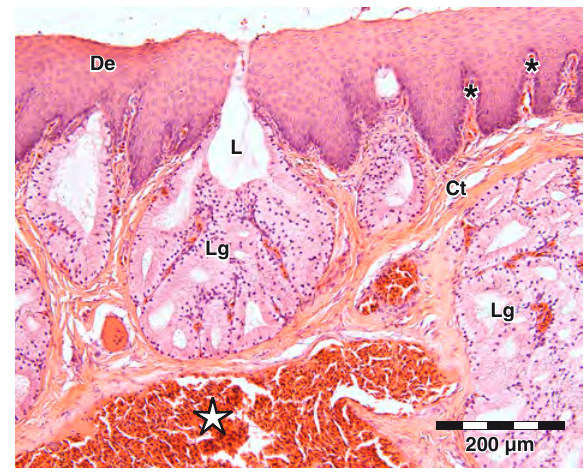
FIG. 4 Low magnification of the tongue dorsum showing the duct of a large, simple branched tubular gland (Lg) passing through the epithelium (De). Lumen (L) nar­ rowing through the epithelium, connective tissue (Ct), connective tissue papillae ( * ), large blood vessel (white star)